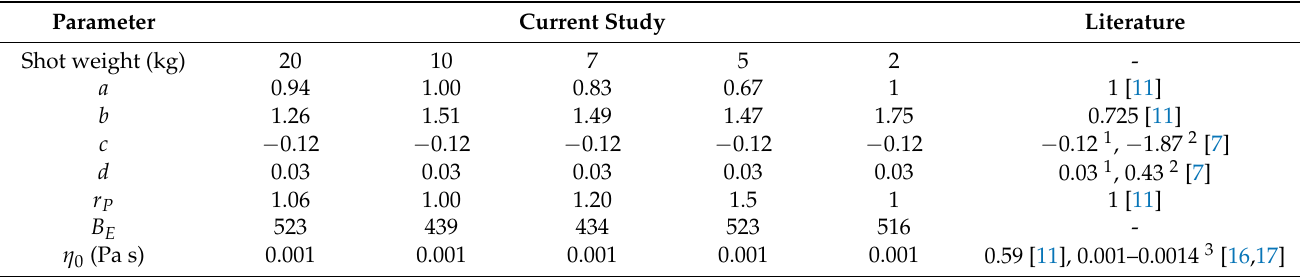
Table 1. Fitted parameters and comparison to